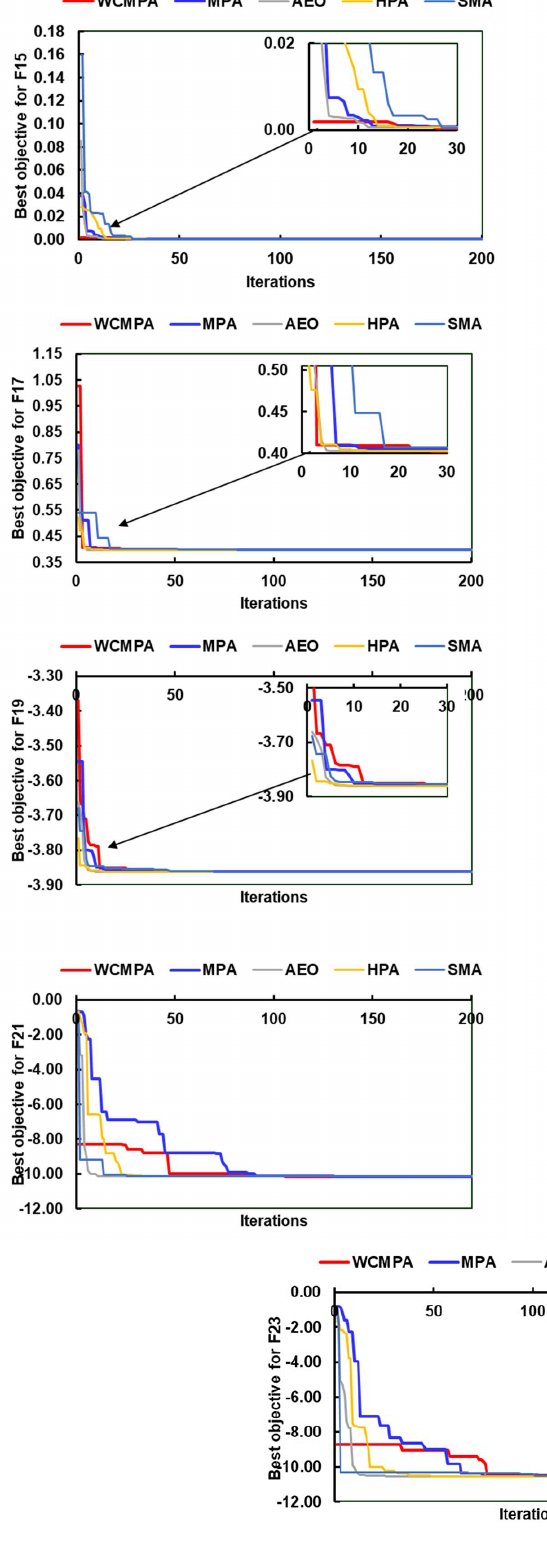
Figure 11. Composite benchmark functions.(E is the Scientific